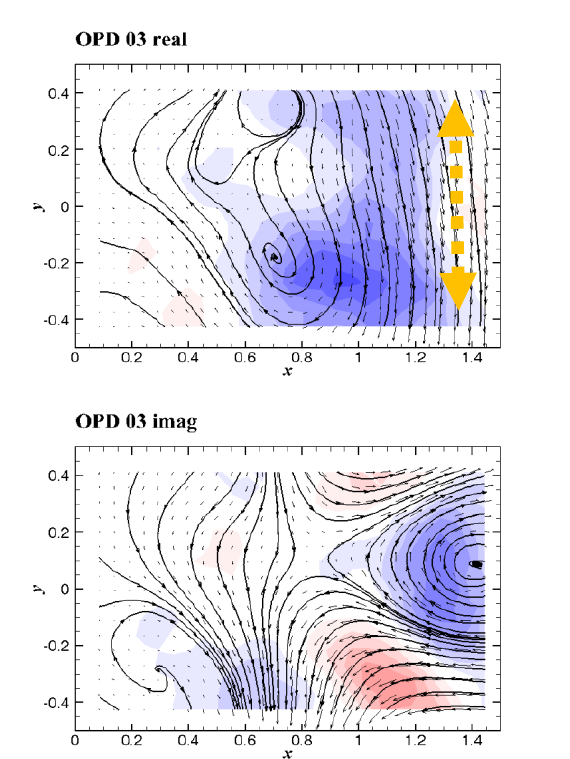
Fig. 12. Topology of the 3 rd OPD mode, real and imaginary parts